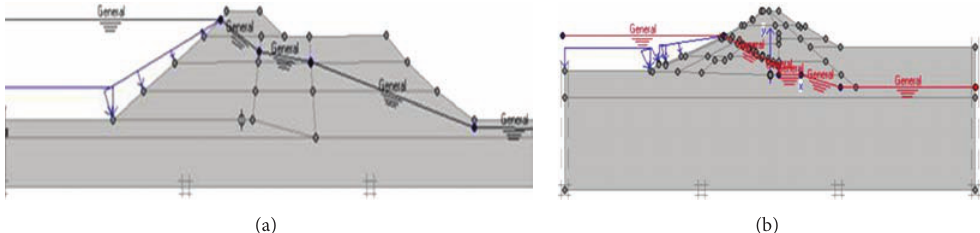
Figure 6: Upstream water level and phreatic line of (a) Upper San Fernando and (b) Kitayama dams.